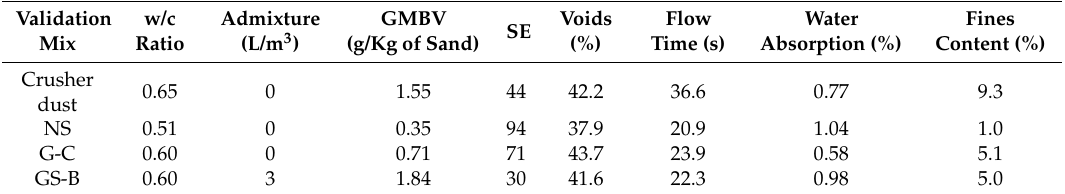
Table 8. Validation mixture input values.